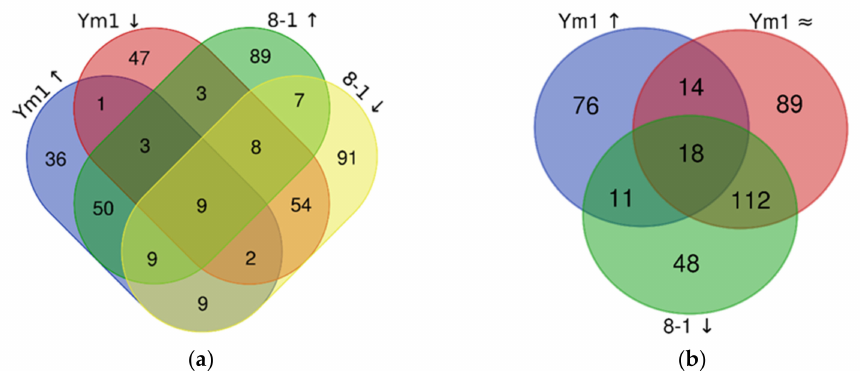
Figure 3. Venn diagrams of DEGs (differentially expressed genes) in L. plantarum strains Ym1 and 8-1 under butanol stress. ( a ) Total number of DEGs in both strains; ( b ) DEGs downregulated in 8-1, overexpressed in Ym1, and genes without significant change in expression in Ym1 ( ± 2-fold change). Symbols: ↑ , overexpressed genes; ↓ , downregulated genes; ≈ , genes without significant change in